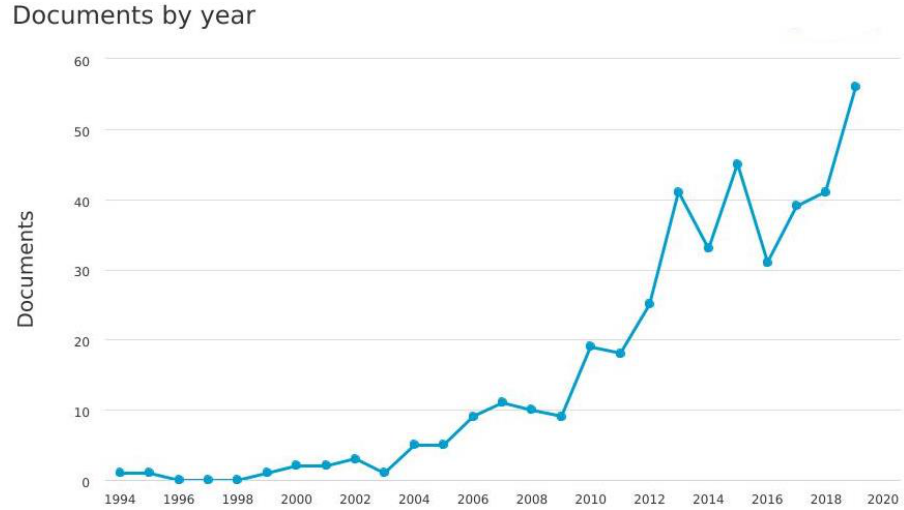
Figure 1. Documents by year.